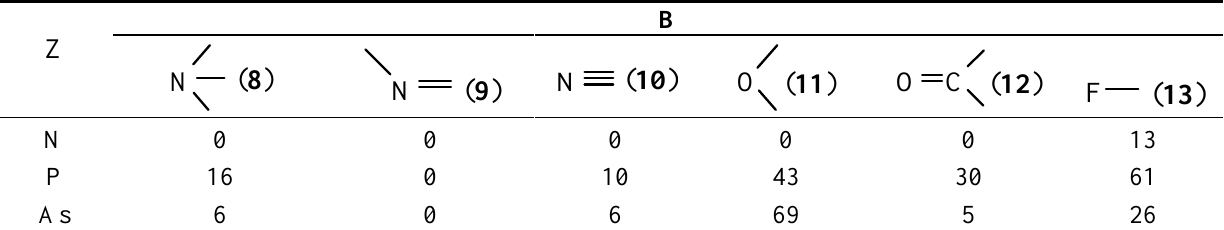
Table 1. Number of close contacts Z---B of various